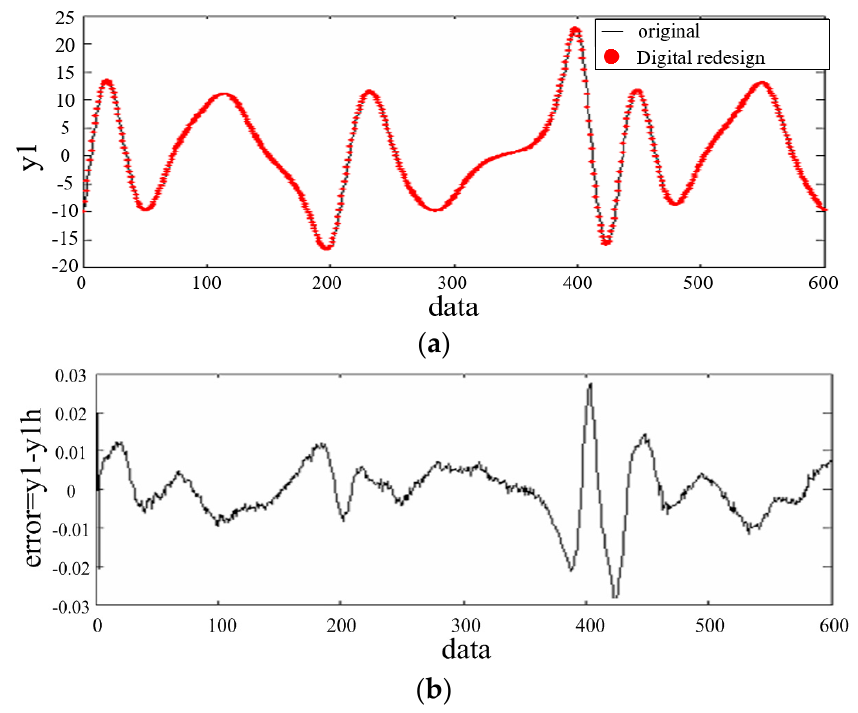
Figure 7. ( a ) Trajectories of and .